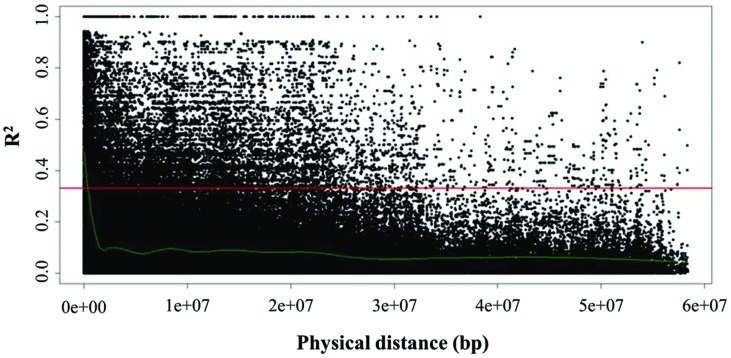
Linkage disequilibrium (LD) represented as r2 of all intrachromosomal marker pairs plotted against physical distance among all linkage groups (O1–O9). The horizontal line (red) marks critical r2 (r2 = 0.33) as threshold beyond which LD is assumed to result from genetic linkage. The intersection point with the non-linear regression LOESS curve (green), which determines LD decay, marks the physical distance as threshold for the maximum distance between genetically linked markers.